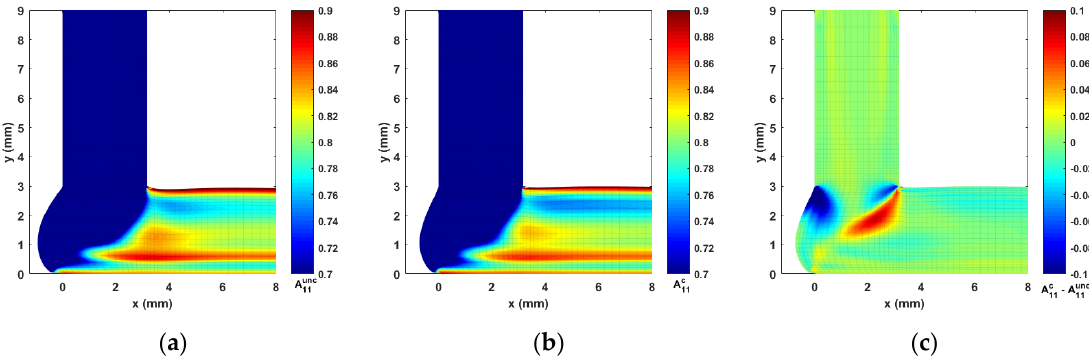
Figure 13. Fiber orientation tensor component contour of A 11 : ( a ) the uncoupled solution; ( b ) the fully coupled solution; ( c ) difference between the fully coupled and uncoupled solutions.